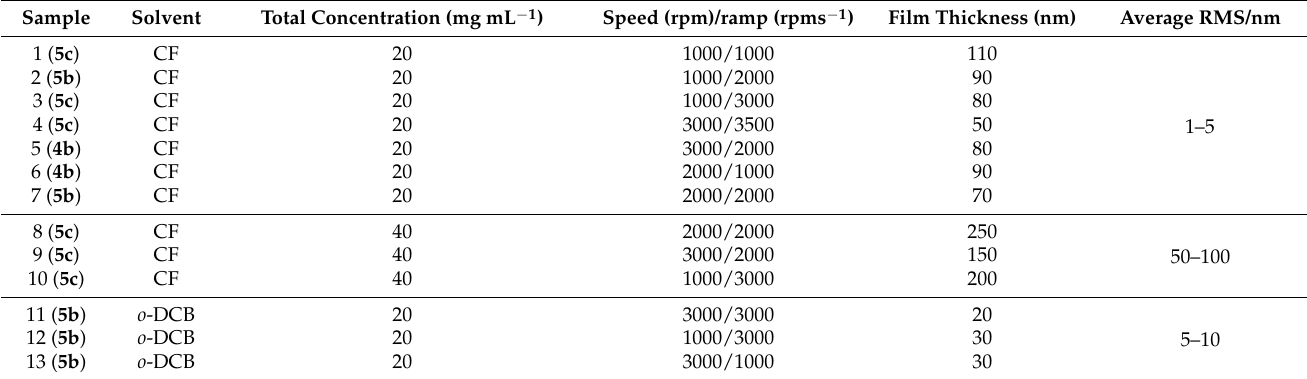
Table 1. Denomination and parameters of the prepared samples. An approximate thickness indicator calculated on behalf of deposition parameters. Root-mean-square roughness (RMS) is shown for groups of samples in similar ranges.